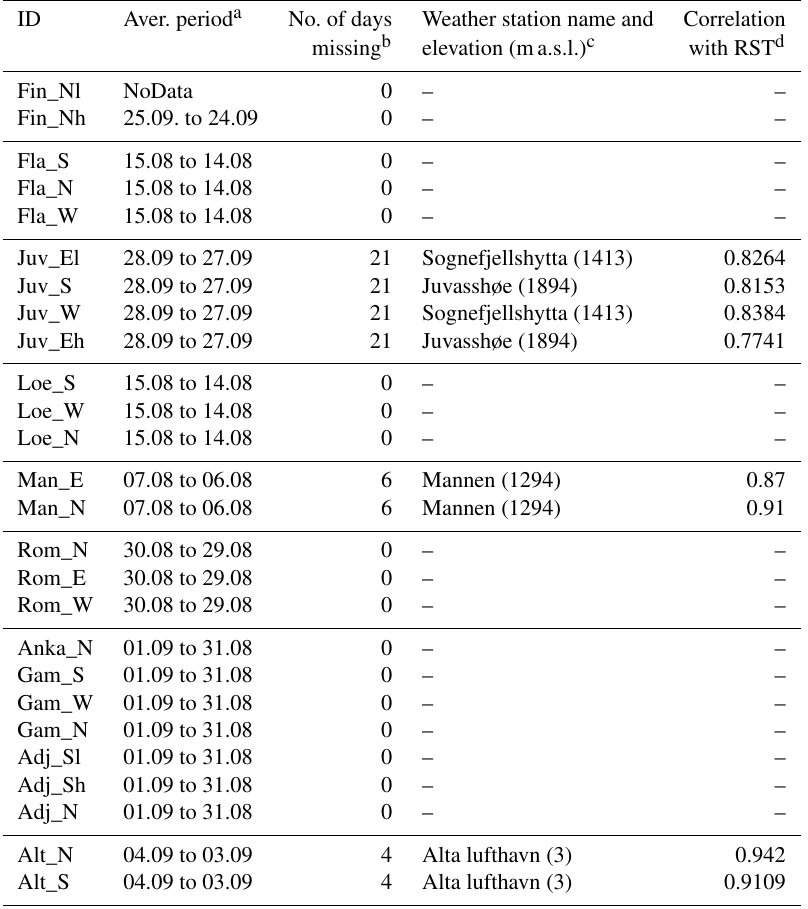
Table 2. Summary of the data used for calculating the